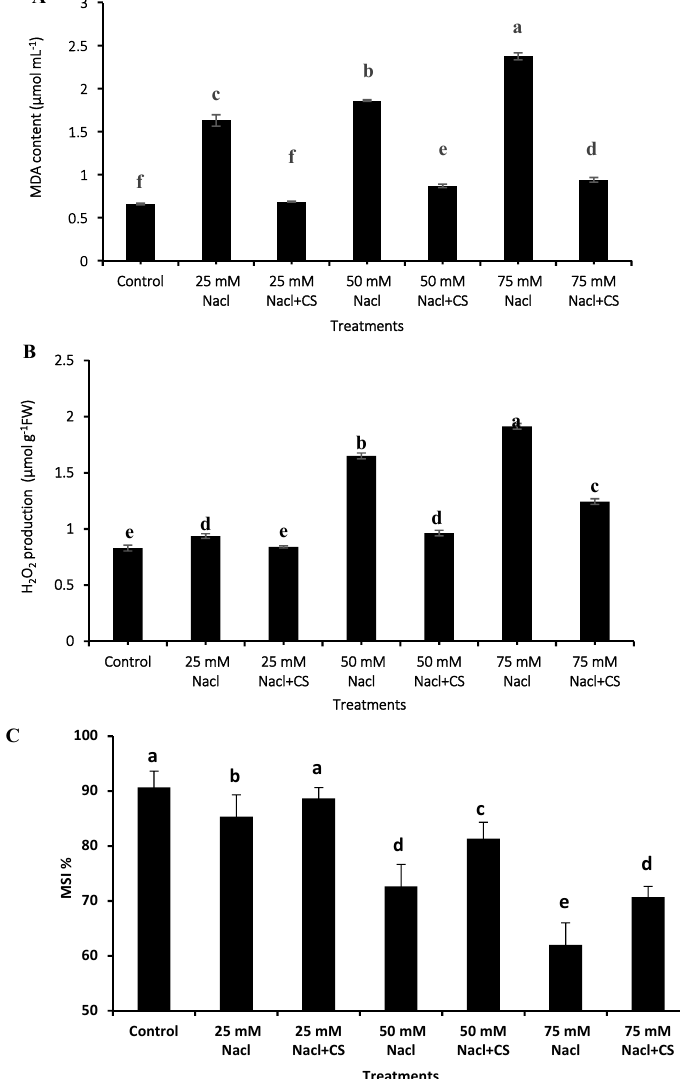
Figure 4. MDA content ( A ), H 2 O 2 production ( B ) and MSI ( C ) of Moringa oleifera exposed to salt stress and sprayed with chitosan (CS) at 1% concentration. Values are means ± SD of two experiments ( n = 6). Columns with different letters are statistically different from each other according to LSD test at p ≤ 0.05.